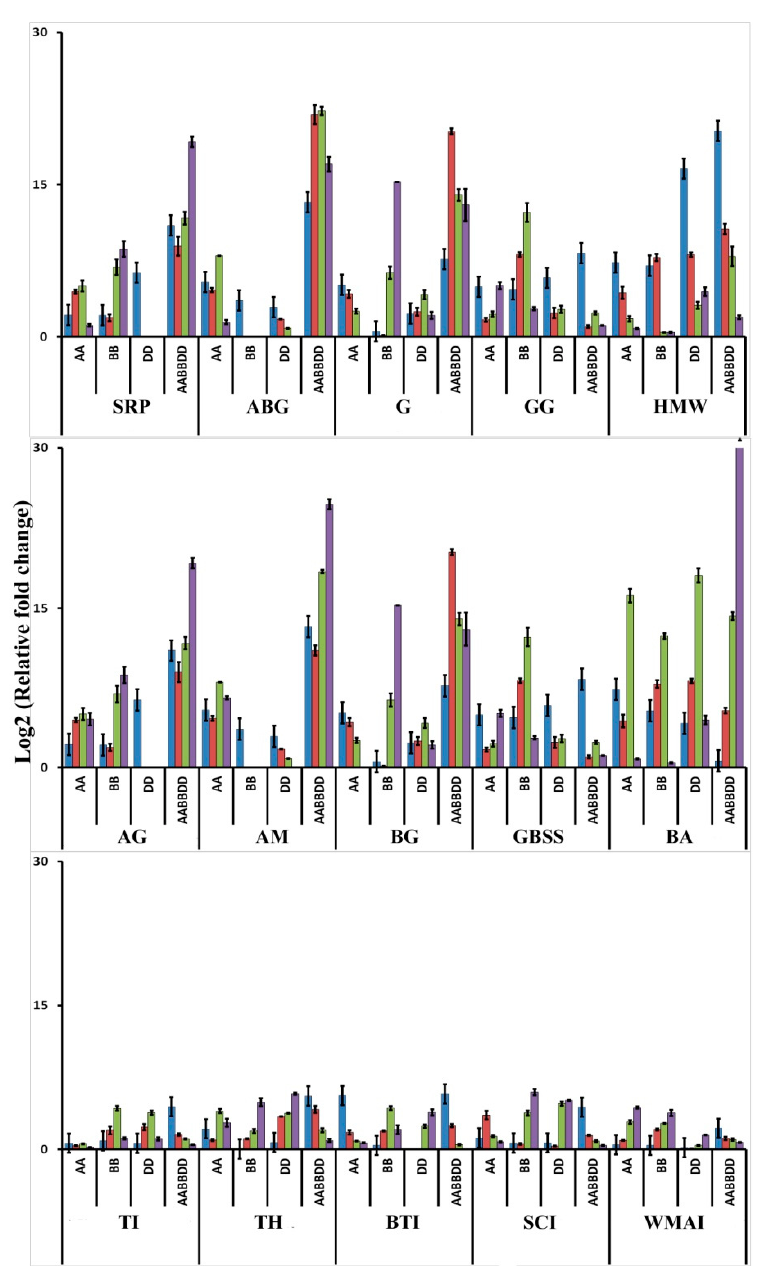
Figure 4. Stage-specific expression (blue—2WAA; red—3WAA; green—4WAA; purple—5WAA) of highly expressed genes belonging to three major classes (NR, CM, and DP) (SRP—sulphur rich seed storage protein; ABG—alpha/beta gliadin; G—germin; GG—gamma gliadin; HMW—high molecular weight glutenin; AG—alpha- glucosidase; AM—alpha-amylase; BG—beta-glucosidase; GBSS—granule bound starch synthase; BA—beta-amylase; TI—trypsin inhibitor CMe; TH—thionin; BTI—Bowman-Birk trypsin inhibitor; SCI—subtilisin chymotrypsin inhibitor; WMAI—wheat monomeric amylase inhibitor)